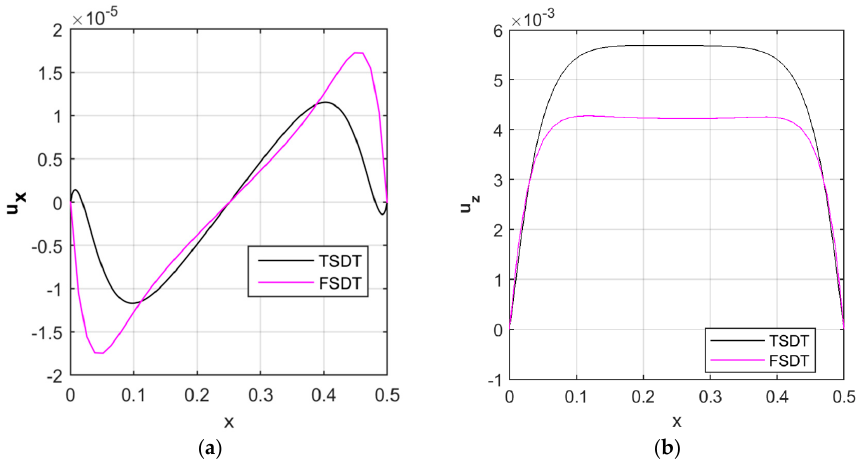
Figure 7. Longitudinal distribution of the axial ( a ) and radial ( b ) displacement components [m], according to the third-order shear deformation theory (TSDT) and first-order shear deformation theory (FSDT).